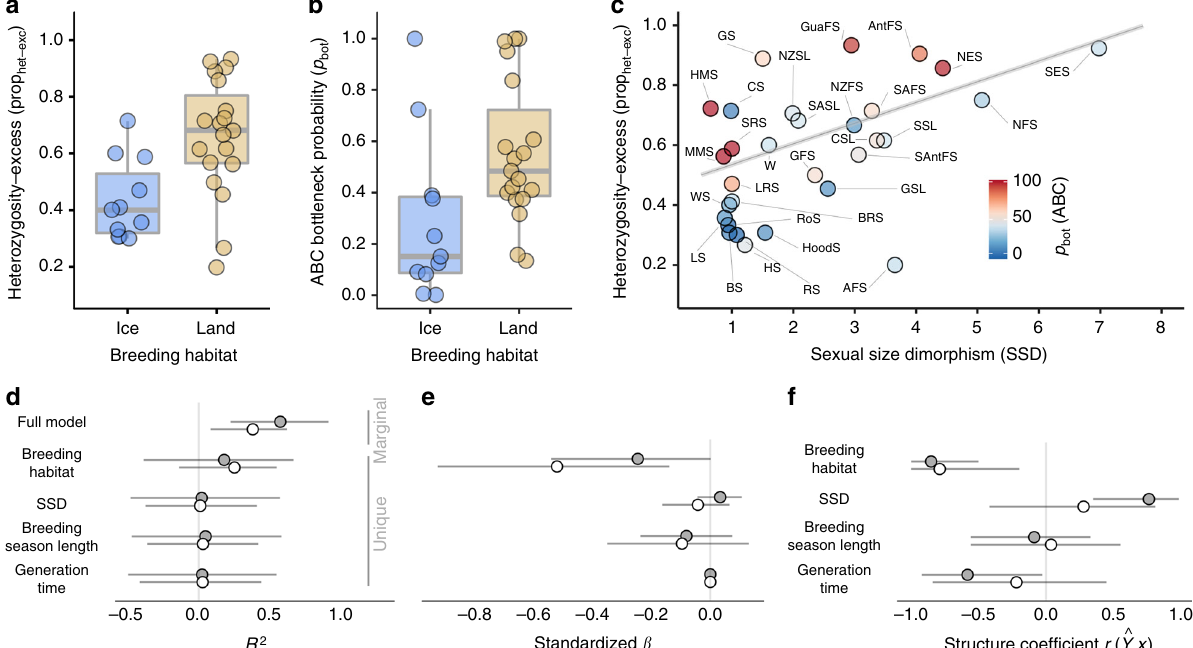
Fig. 3 Ecological and life-history effects on bottleneck signatures. Shown are the results of phylogenetic mixed models of prop het-exc and p bot with breeding habitat, SSD, breeding season length and generation time fi tted as fi xed effects. a , b Show differences between ice-breeding and land-breeding species in prop het-exc and p bot respectively. Raw data points are shown together with boxplots (centre line = median, bounds of box = 25th and 75th percentiles, upper and lower whiskers = largest and smallest value but no further than 1.5 * inter-quartile range from the hinge). c Shows the relationship between sexual size dimorphism (SSD) and prop het-exc , with individual points colour coded according to the ABC bottleneck probability ( p bot ) and the line representing the predicted response from the prop het-exc model. Marginal and unique R 2 values, standardized β coef fi cients and structure coef fi cients are shown for models of prop het-exc ( fi lled points) and p bot (open points) in d – f , where they are presented as posterior medians with 95% credible intervals. Species abbreviations are given in Fig. 1 and Supplementary Table